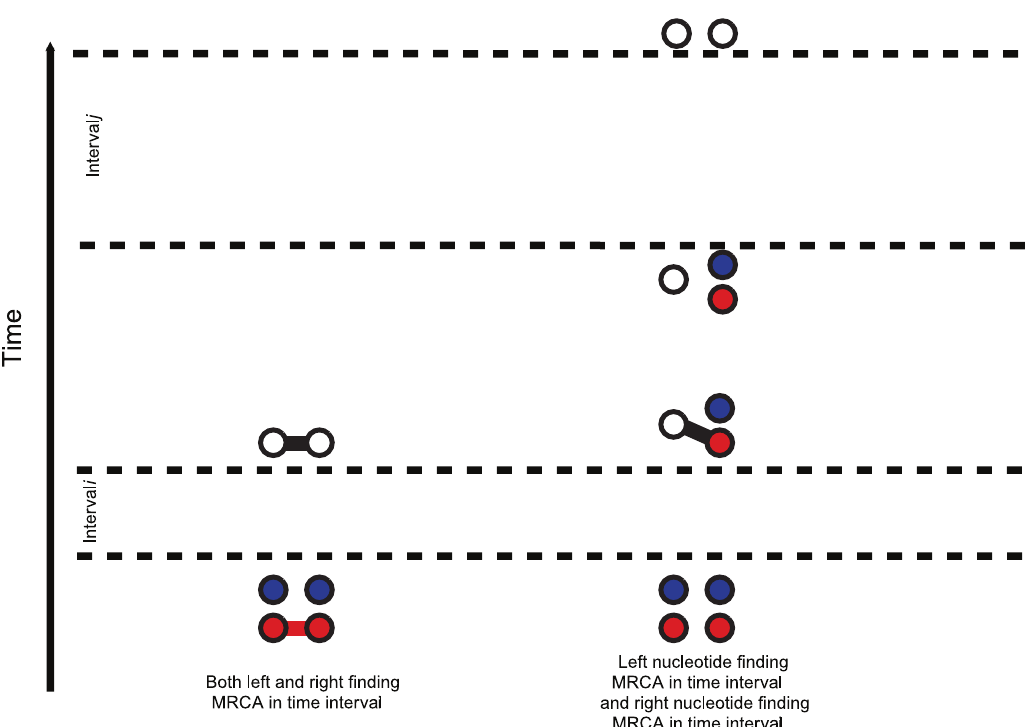
Figure 7. Transition probabilities calculated from the CTMC system. The hidden Markov model transition probabilities are calculated by considering the probabilities, in the two nucleotide CTMC system, that either both left and right nucleotide finds a most recent common ancestor in the same time interval (left) or that the left nucleotide finds a most recent common ancestor in one given interval, i , and the right in another, j (right).